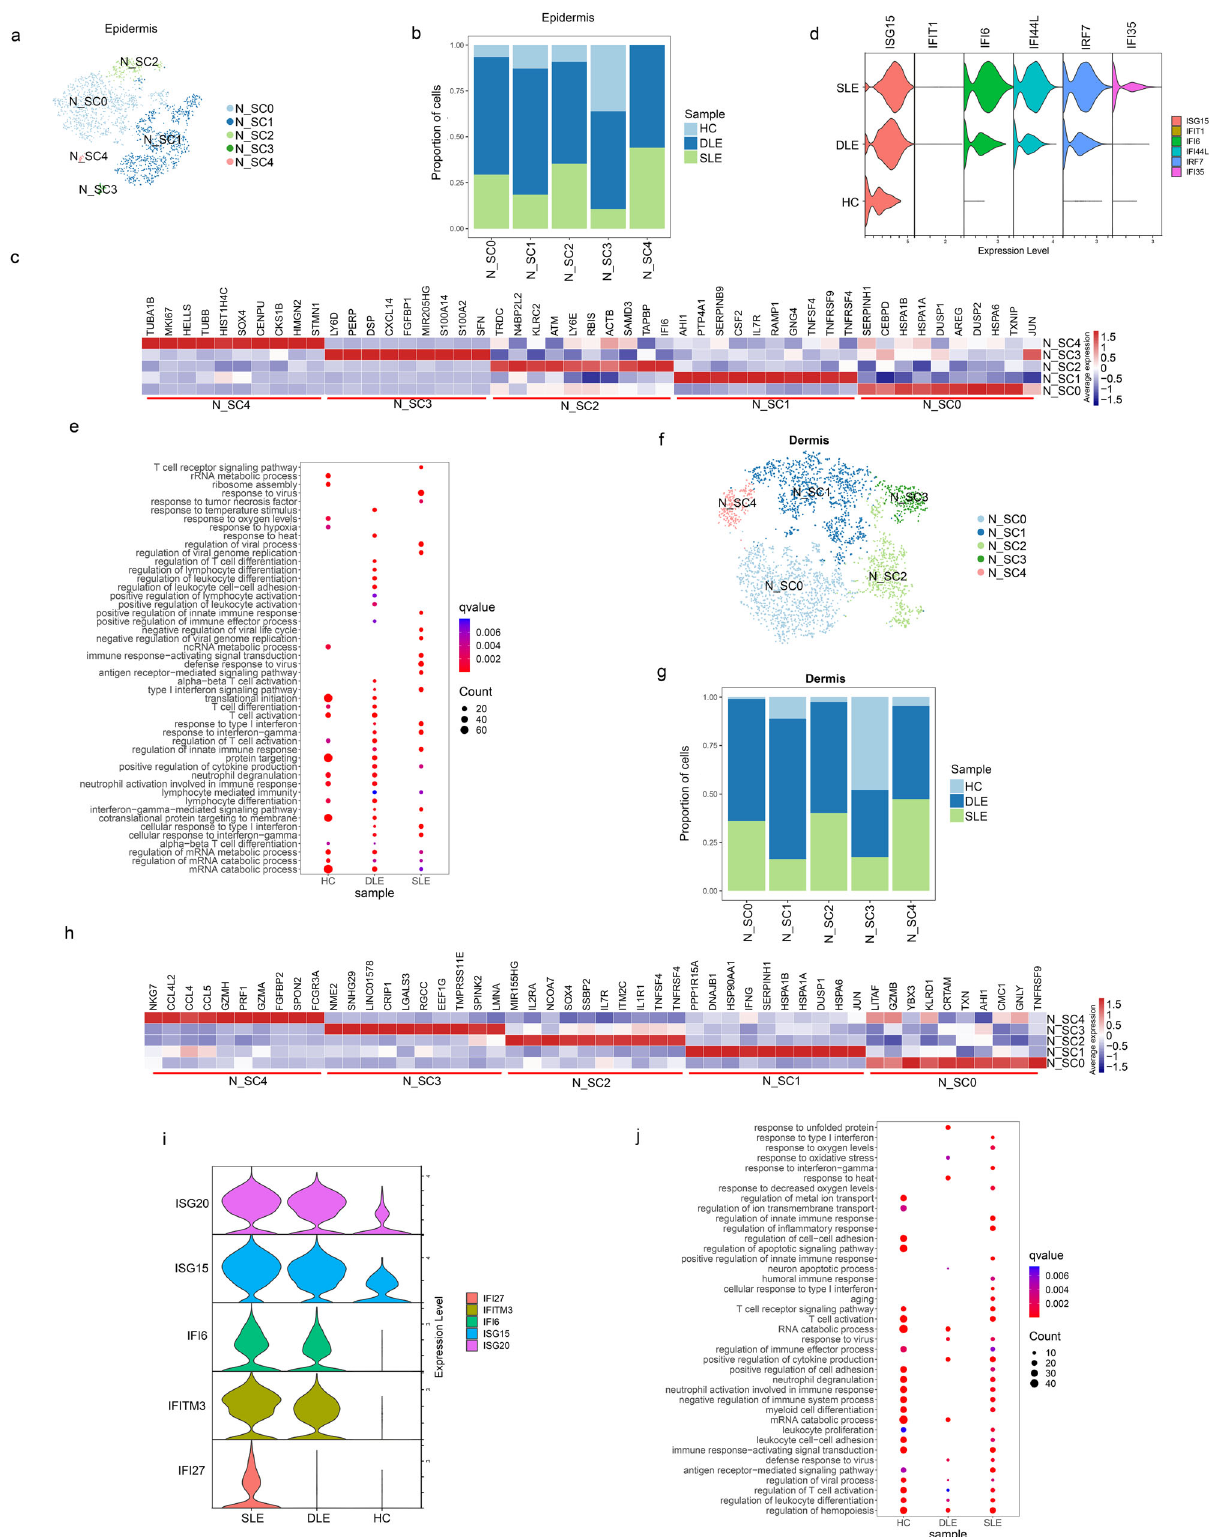
Fig. 8 | Sub-clustering analysis of NK cells identi fi es major NK subclusters. a , f t-SNEs plot show cell distribution of epidermal ( a ) and dermal NK subclusters (SCs)( f ). b , g BarplotshowsthesampleproportionsinNKcellSCsofepidermis( b ) anddermis( g ). c , h Heatmapsindicatethetop10differentiallyexpressedgenesin5 epidermalNKcellSCs( c )and5dermalNKcellSCs( h ). d , i Stackedviolinplotshow